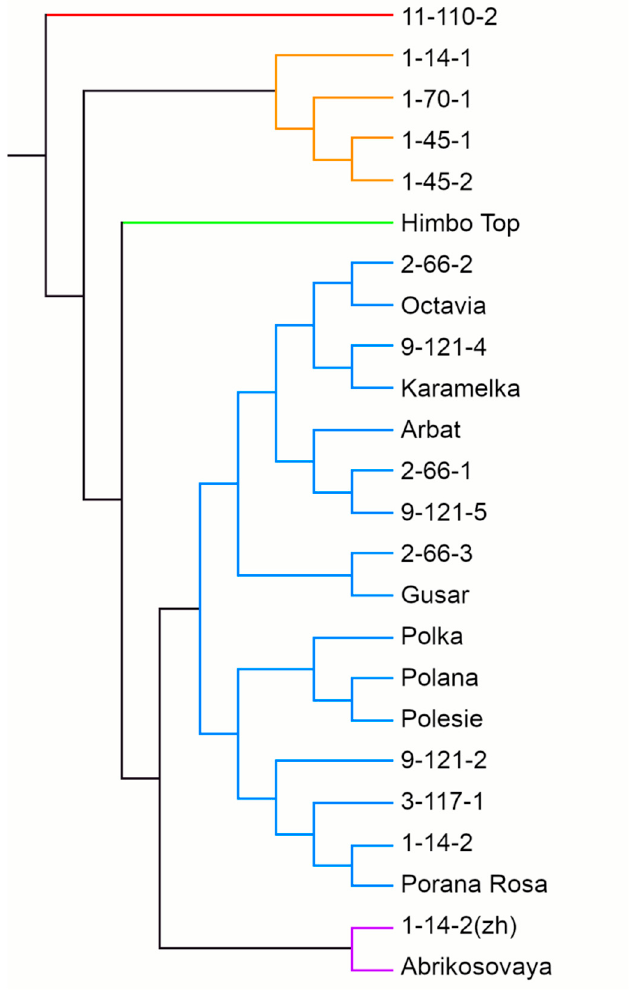
Figure 5. The UPGMA dendrogram of the 24 red raspberry genotypes calculated using SSR markers.